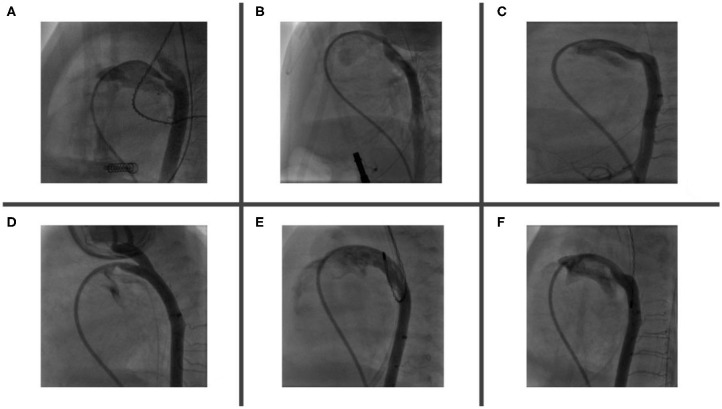
PDA morphology and size are extremely variable in premature babies. Angiogram helps to delineate duct features, accurately measures both PDA's aortic and pulmonary ends and choose the most appropriate device. Angiogram performed through a catheter via RV—MPA—PDA—Descending aorta. Six types of described PDA morphologies have been demonstrated in figures (A–F). (A) Relatively long duct with mid-course constriction. (B) Long and tortuous duct with pulmonary end constriction. (C) Long and tortuous duct with widely open pulmonary and aortic ends. (D) Short duct with pulmonary end constriction and LPA origin stenosis. (E) Extremely large and dilated duct (note that its diameter is bigger than descending aorta) and (F) Long and tortuous duct with variable diameter along its course (RV, right ventricle; MPA, main pulmonary artery; LPA, left pulmonary artery; PDA, patent ductus arteriosus).